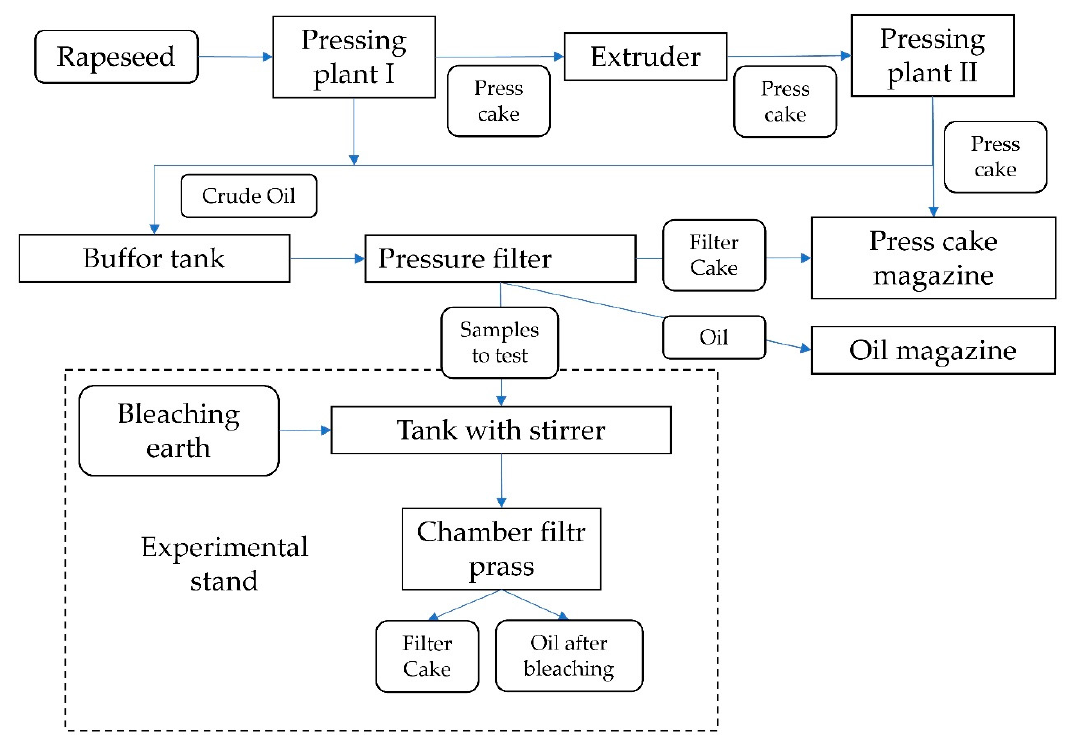
Figure 1. Diagram of oil production technology and experimental stand.